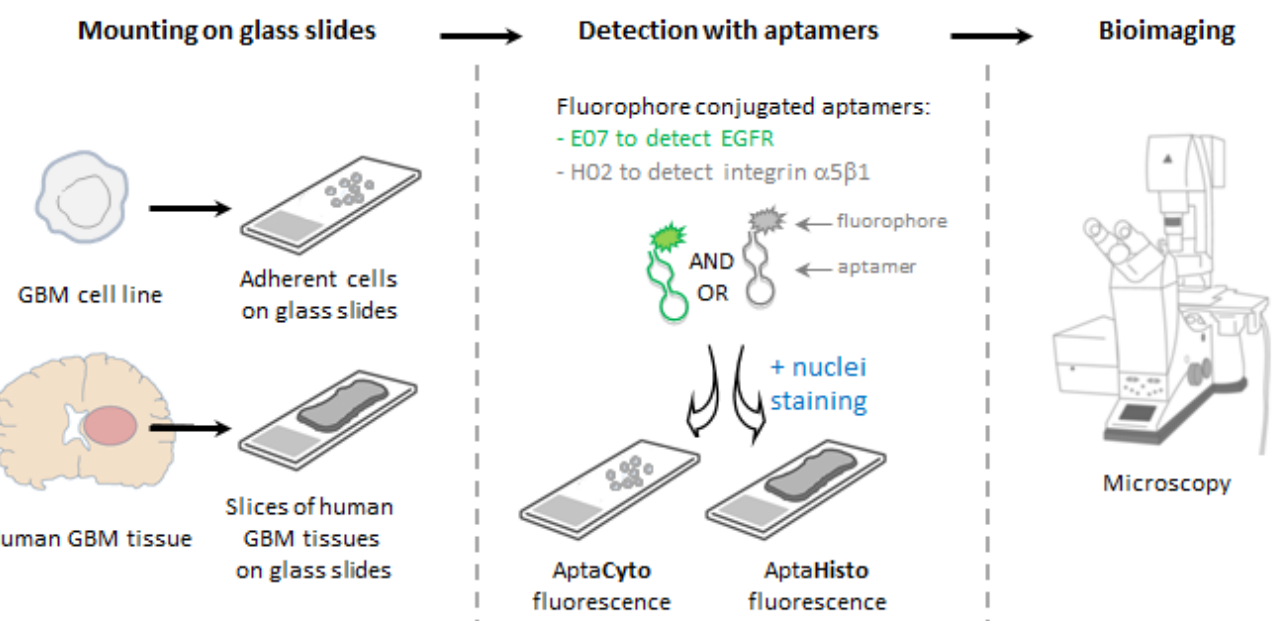
Figure 1. Experimental scheme illustrating the aptafluorescence experiments. After mounting GBM cells or tissues on glass, cells or tissues were incubated with aptamers covalently conjugated to fluorophores. Two aptamers with different specificities were used in this study: aptamer E07 to detect EGFR and aptamer H02 to detect integrin α 5 β 1. At the end of this manuscript, we also describe a technique in which both aptamers were simultaneously incubated on GBM tissues (multiplexing experiments). Fluorescence microscopy was then realized for bioimaging. Drawings are not to